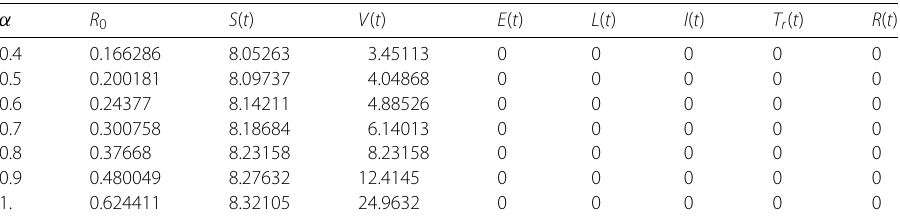
Table 3 Basic reproduction number R 0 and disease-free equilibrium point (cid:13) 1 for set 1 and τ = 1 at different values of α α R 0 S ( t ) V ( t )